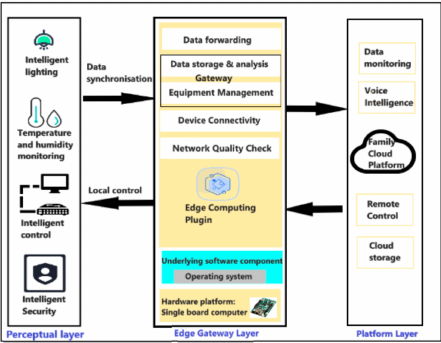
Figure 6. IoT Edge Gateway Smart Home Reference